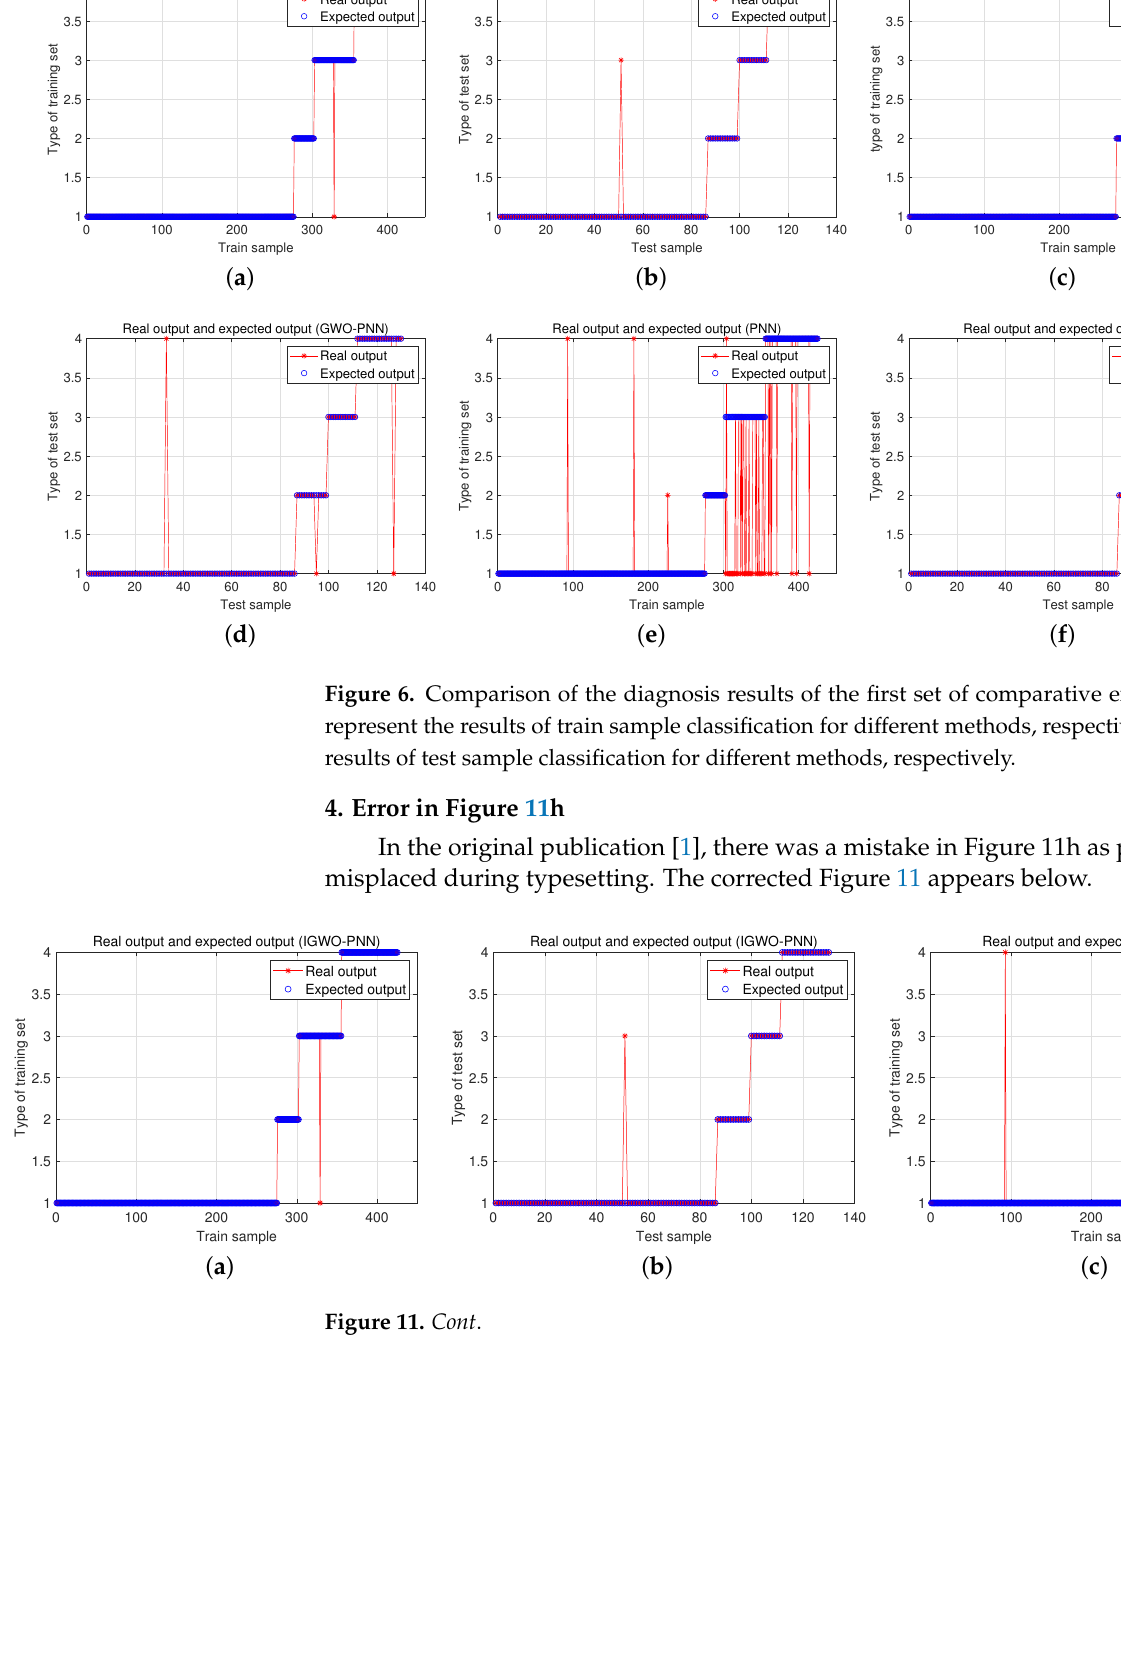
12 of 21 Table 4. Parameter setting of various methods. Methods Parameters Settings PSO-BP